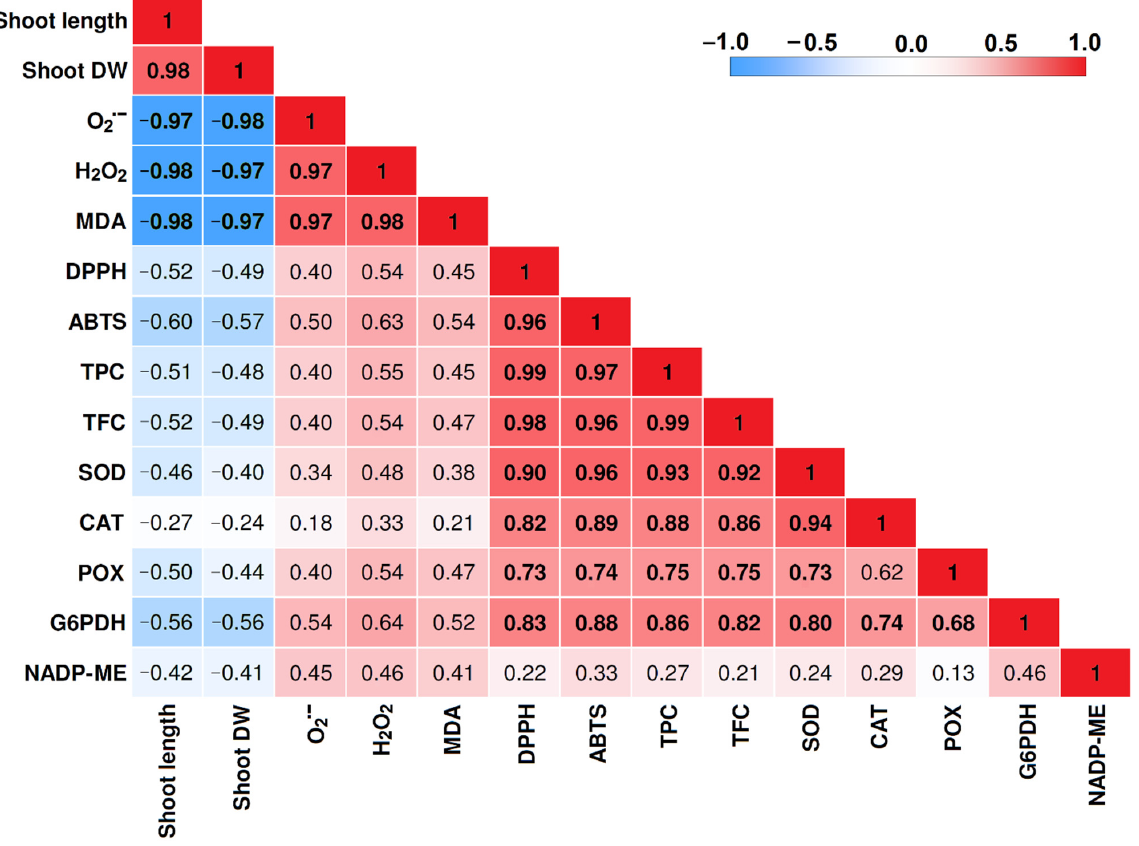
Figure 4. Correlation matrix for the traits analyzed in the shoot of durum wheat seedlings. Red indicates positive correlation and blue indicates negative correlation. Correlations significant at p ≤ 0.01 are highlighted in bold.